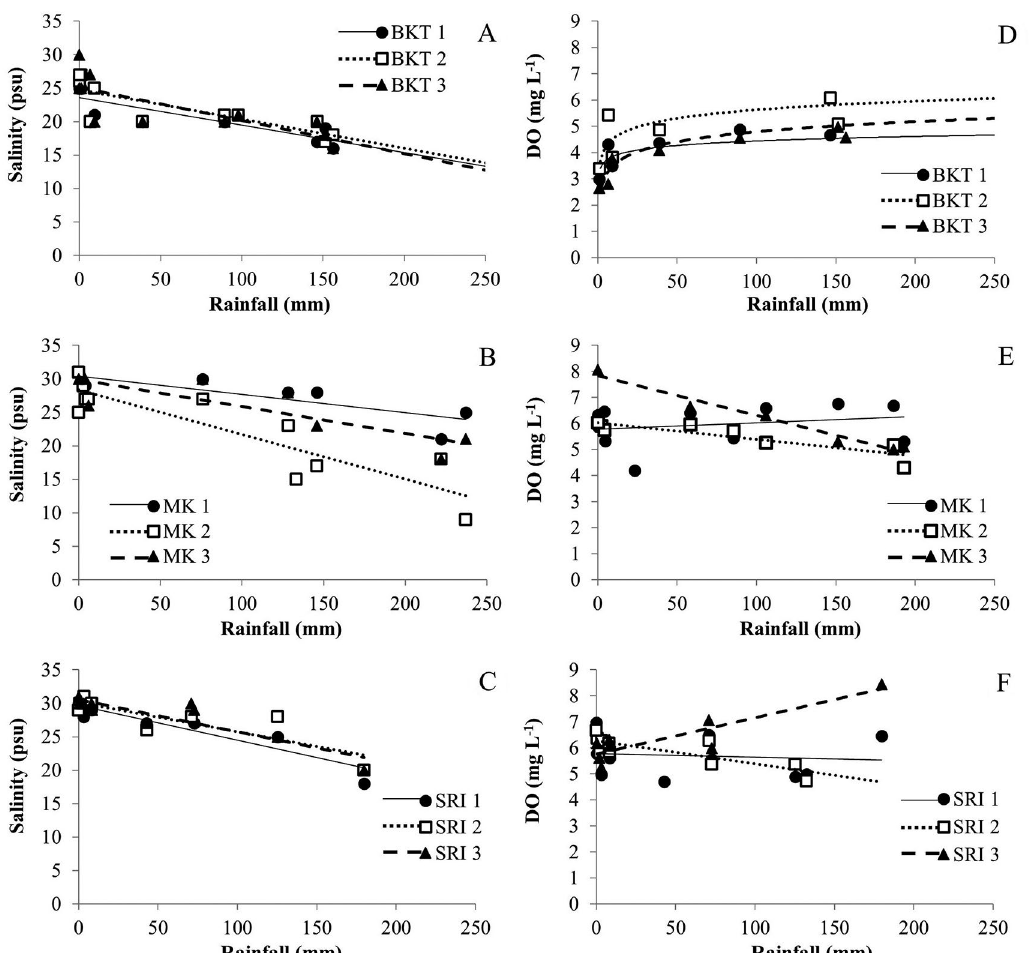
Fig. 3. – Correlation between rainfall and salinity (A, B and C), and correlation between rainfall and dissolved oxygen (DO) (D, E, and F) at each sampling station in the pond area of Bang Khun Tien (BKT), the estuary area of the Maeklong river mouth (MK), and the coastal area of Sriracha (SRI) based on monthly measurements from January to December